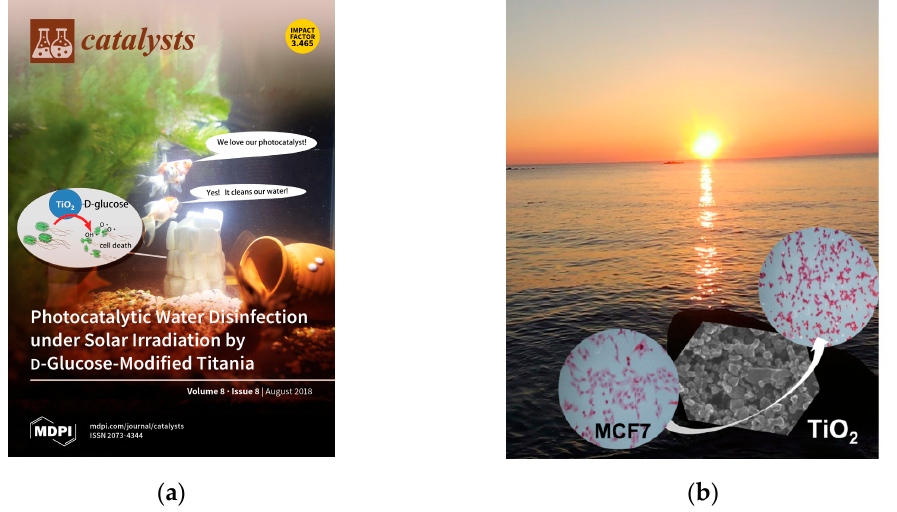
Figure 2. Examples of possible microbiological applications of titania photocatalysts: ( a ) modified titania with D-glucose for disinfection of water tanks (journal cover image; https: // res.mdpi.com / data / covers / catalysts / big_cover-catalysts-v8-i8.png) and ( b ) decomposition of breast adenocarcinoma MCF7 cells (ATCC ® HTB-22 ™ , breast adenocarcinoma cell line from human) on commercial titania (P25) irradiated with UVA / vis (graphical abstract); adapted with permission from [75] and [80], respectively. Copyright 2018 and 2020, respectively, Creative Commons